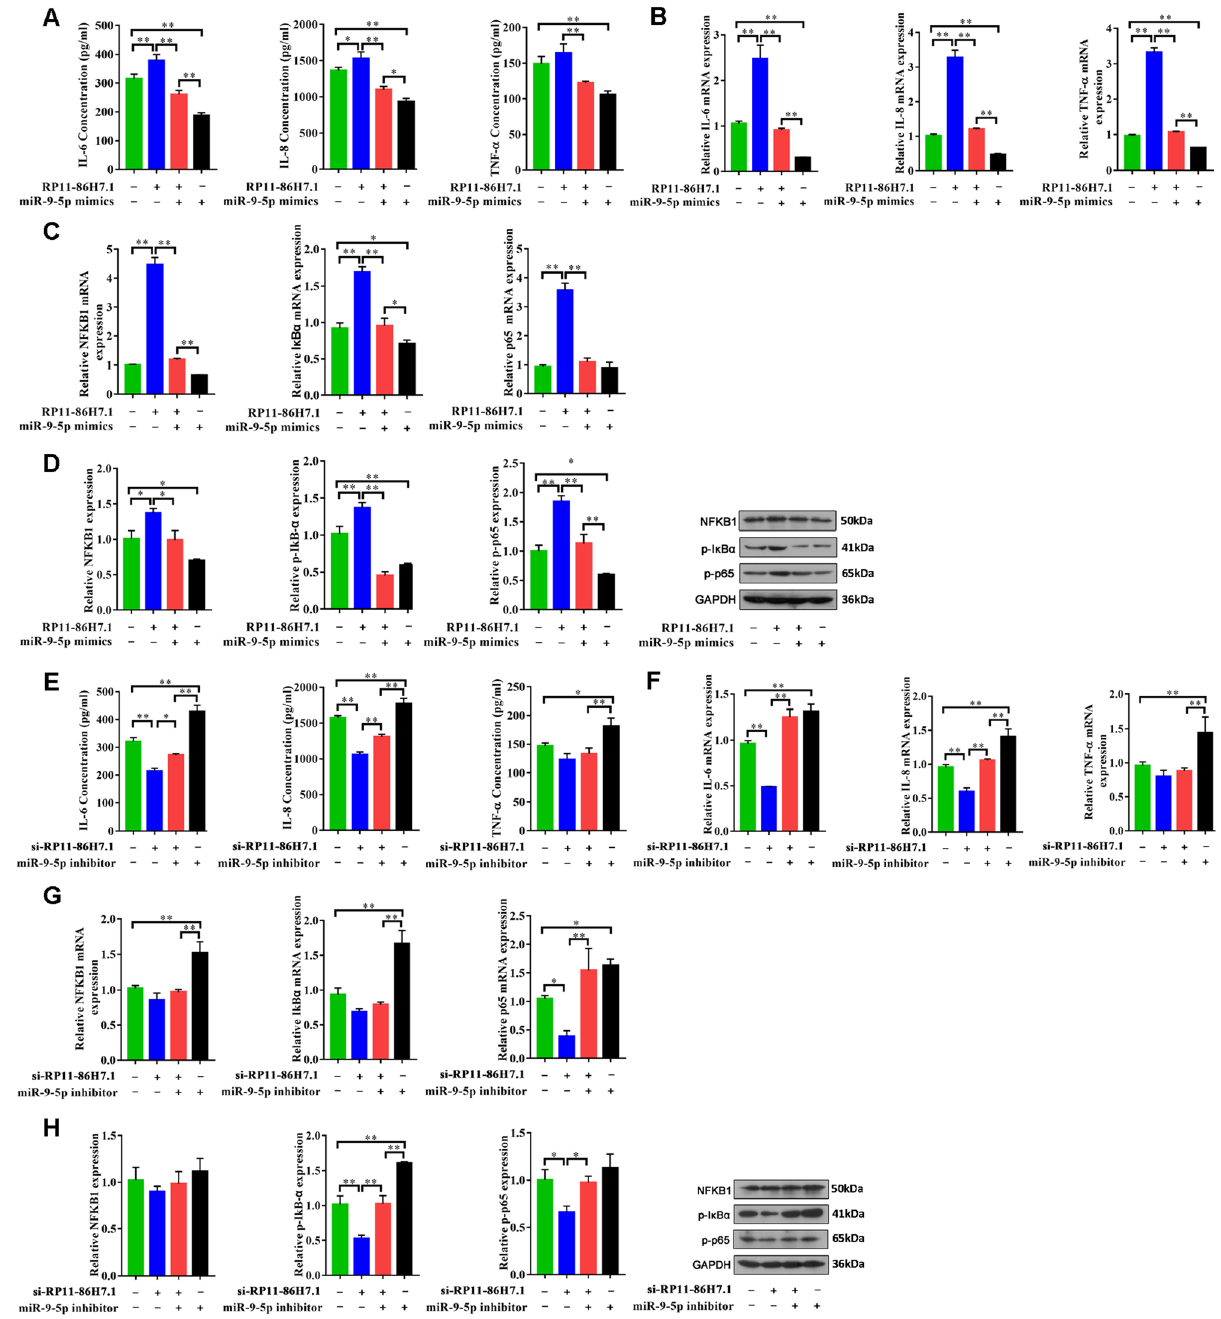
Figure 7. LncRNA RP11-86H7.1 acts as a ceRNA by sponging miR-9-5p to upregulate their common target, NFKB1 and promote inflammatory response by the gain and loss of function assay. ( A ) ELISA analysis of IL-6, IL-8, and TNF-α levels in 16HBE cells co-transfected with lncRNA RP11-86H7.1 or miR-9-5p mimic. ( B, C ) Q-PCR analysis of the mRNA expression levels of IL-6, IL-8, TNF-α, lncRNA RP11-86H7.1, NFKB1, IκBα, and p65 in 16HBE cells co-transfected with lncRNA RP11-86H7.1 or miR-9-5p mimic. ( D ) Western blotting analysis of the protein levels of NFKB1, p-IκBα and p-p65 in 16HBE cells co-transfected with lncRNA RP11- 86H7.1 or miR-9-5p mimic. GAPDH was used as an internal control. ( E ) ELISA analysis of IL-6, IL-8, and TNF-α levels 16HBE cells co-transfected with lncRNA RP11-86H7.1 knockdown or miR-9-5p inhibitor. ( F, G ) Q-PCR analysis of the mRNA expression levels of IL-6, IL-8, TNF-α, lncRNA RP11-86H7.1, NFKB1, IκBα, and p65 in 16HBE cells co-transfected with lncRNA RP11-86H7.1 knockdown or miR-9-5p inhibitor. ( H ) Western blot analysis of the protein levels of NFKB1, p-IκBα and p-p65 in 16HBE cells co-transfected with lncRNA RP11-86H7.1 knockdown or miR-9-5p inhibitor. GAPDH was used as an internal control. The data are shown as the means ± standard deviations (n = 3). The statistical significance of the data was assessed by Student’s t test. * P < 0.05, ** P <